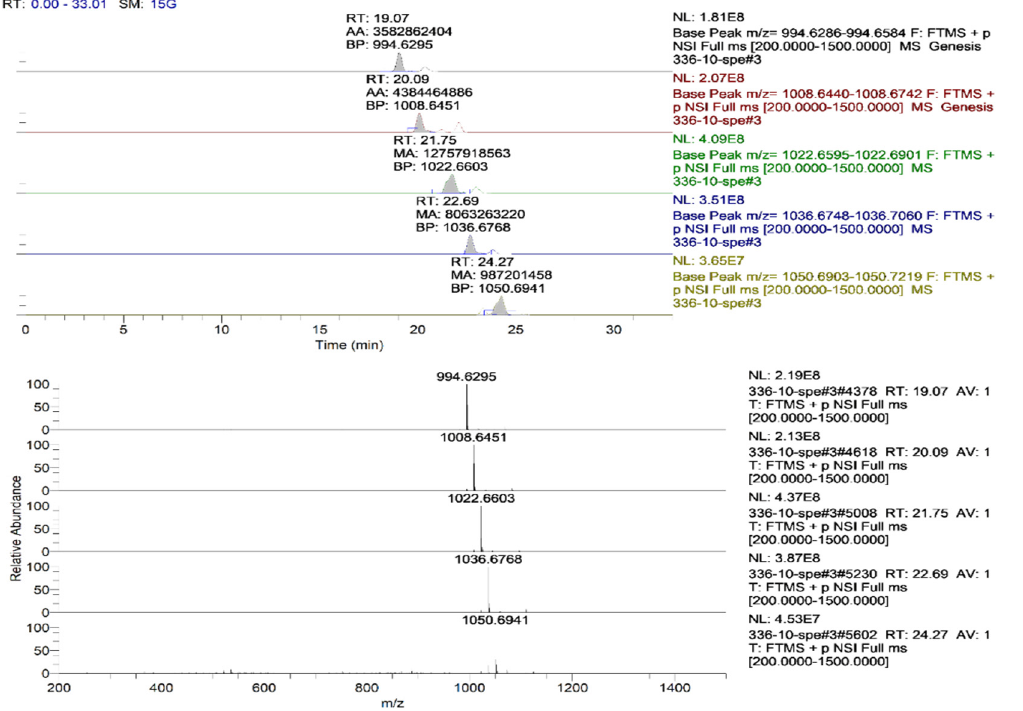
Figure 11. HPLC-ESI+-HRMS spectra of Surfactin A-CH 2 , Surfactin A, Surfactin B, Surfactin C, and Surfactin C + CH 2 for sample BZR 336 g.